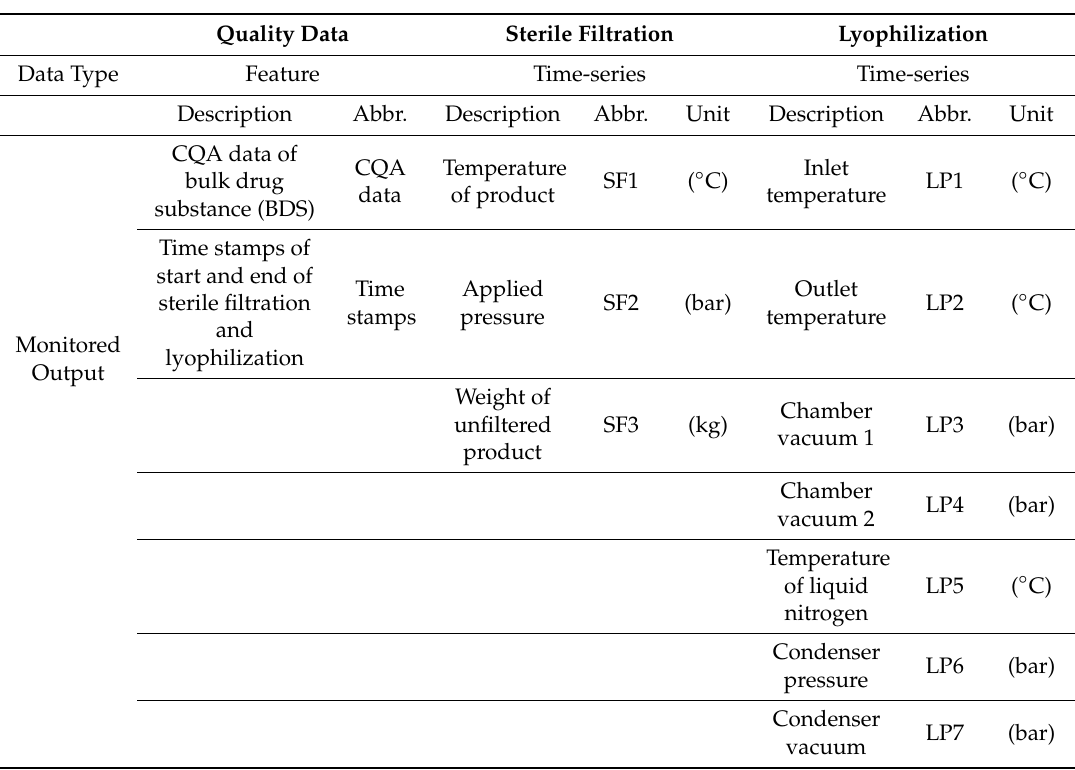
Table 1. Overview of the quality data, sterile filtration (SF) and lyophilization (LP) data sources, including their data content, abbreviation and